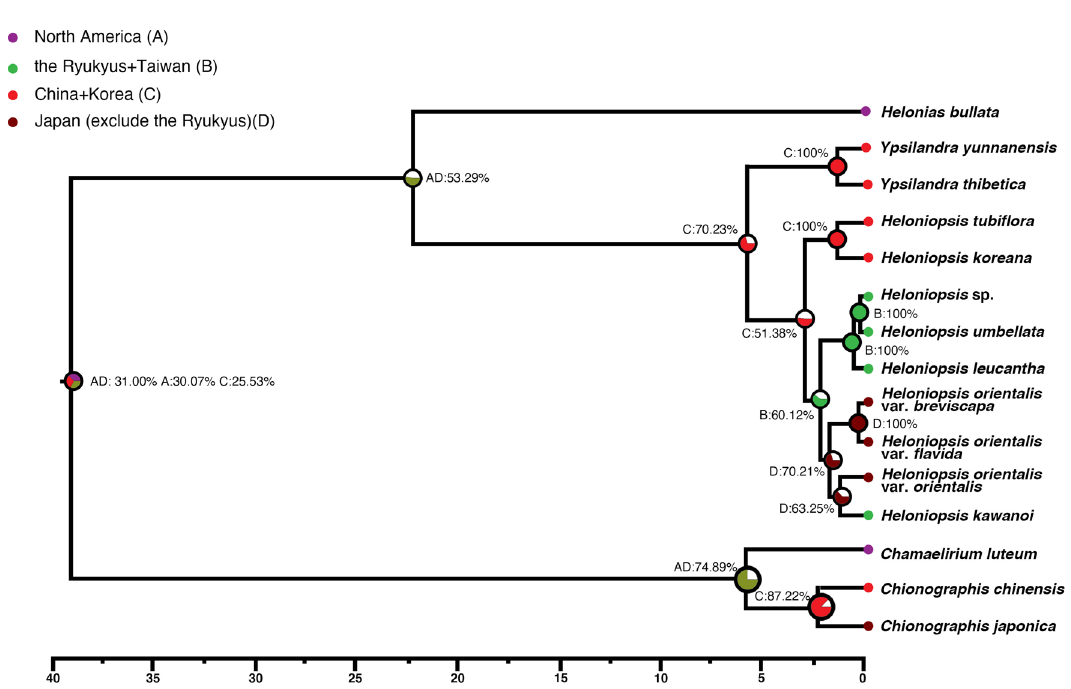
Figure 2. Ancestral area of Heloniadeae reconstructed by RASP with probability on each node, the color in the pie chart showing the ancestral area with over 50%